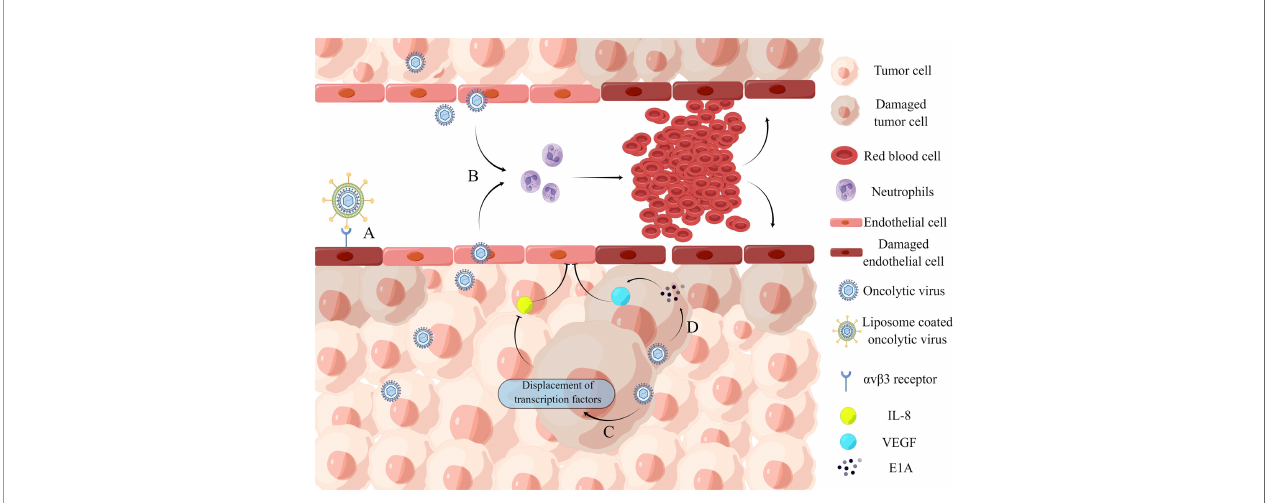
FIGURE 2 | Inhibition of intra-tumor angiogenesis. (A) Binding of iRGD liposome-encapsulated oncolytic virus to a v b 3 receptor directly induces lysis of HUVECs. (B) Oncolytic virus infection causes the recruitment of a large number of neutrophils and the formation of microthrombosis, resulting in the loss of blood perfusion and the increase of tumor cell apoptosis caused by ischemia. (C) Oncolytic virus dl922-947 treatment reduces IL-8 production in ATC cell lines by displacing the transcription factor NF- k B p65 from the IL8 promoter, thereby inhibiting tumor angiogenesis. (D) Adenovirus can express E1A protein, which can downregulate VEGF by interacting with angiogenic proteins, thereby affecting neointima in the tumor microenvironment and ultimately achieving tumor